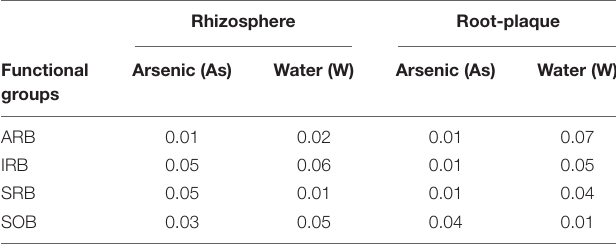
TABLE 3 | PERMANOVA p- values for experimental variables (arsenic and water treatments) on the gene-probe relative intensities in the rice rhizosphere and the root-plaque